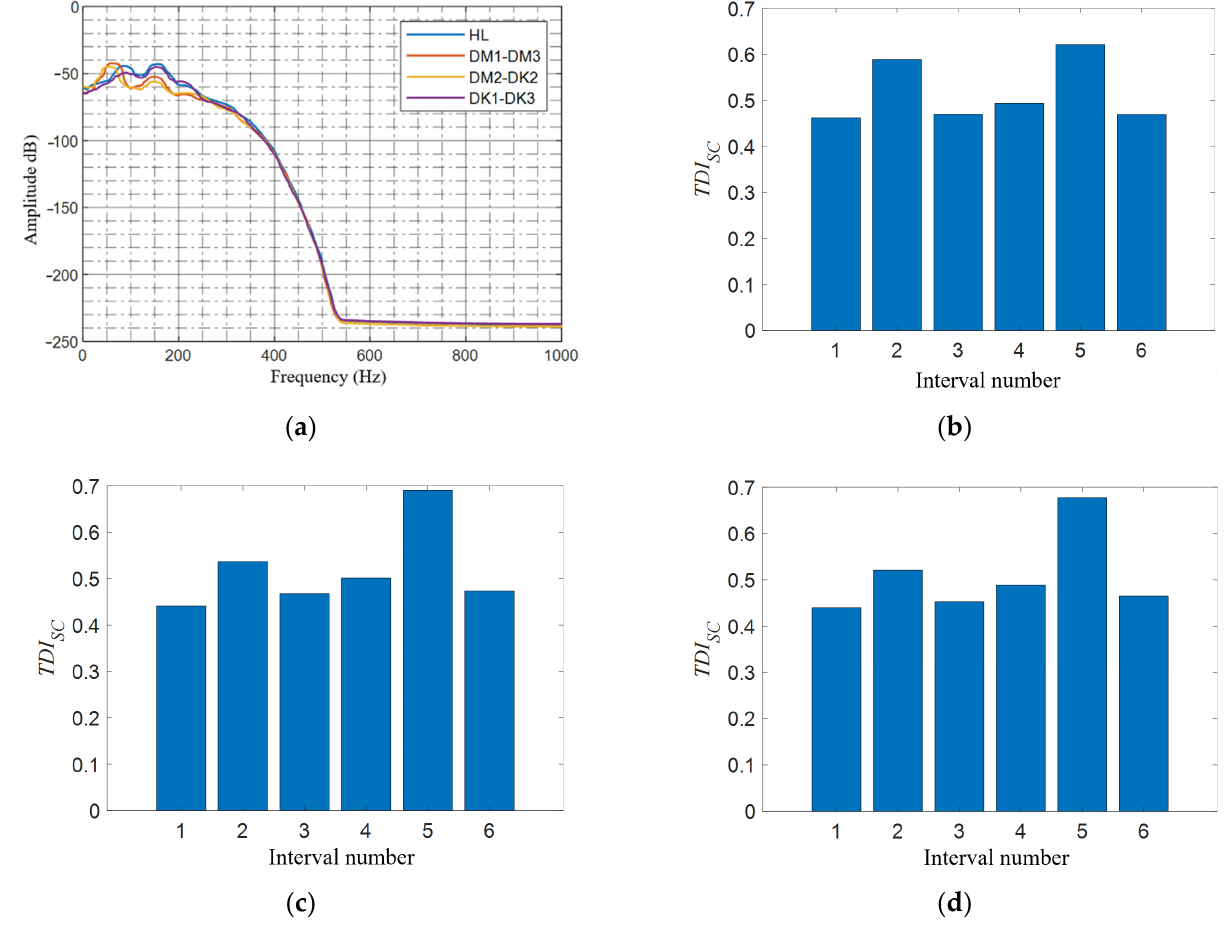
Figure 19. TDI SC validation in two different types of damage: ( a ) power spectrum curve of the tunnel acceleration under two different damages in the second and fifth interval; ( b ) TDI SC at additional mass damage in the second and fifth interval; ( c ) TDI SC at additional mass damage in the second interval and stiffness damage in the fifth interval; and ( d ) TDI SC at stiffness damage in the second and fifth interval.